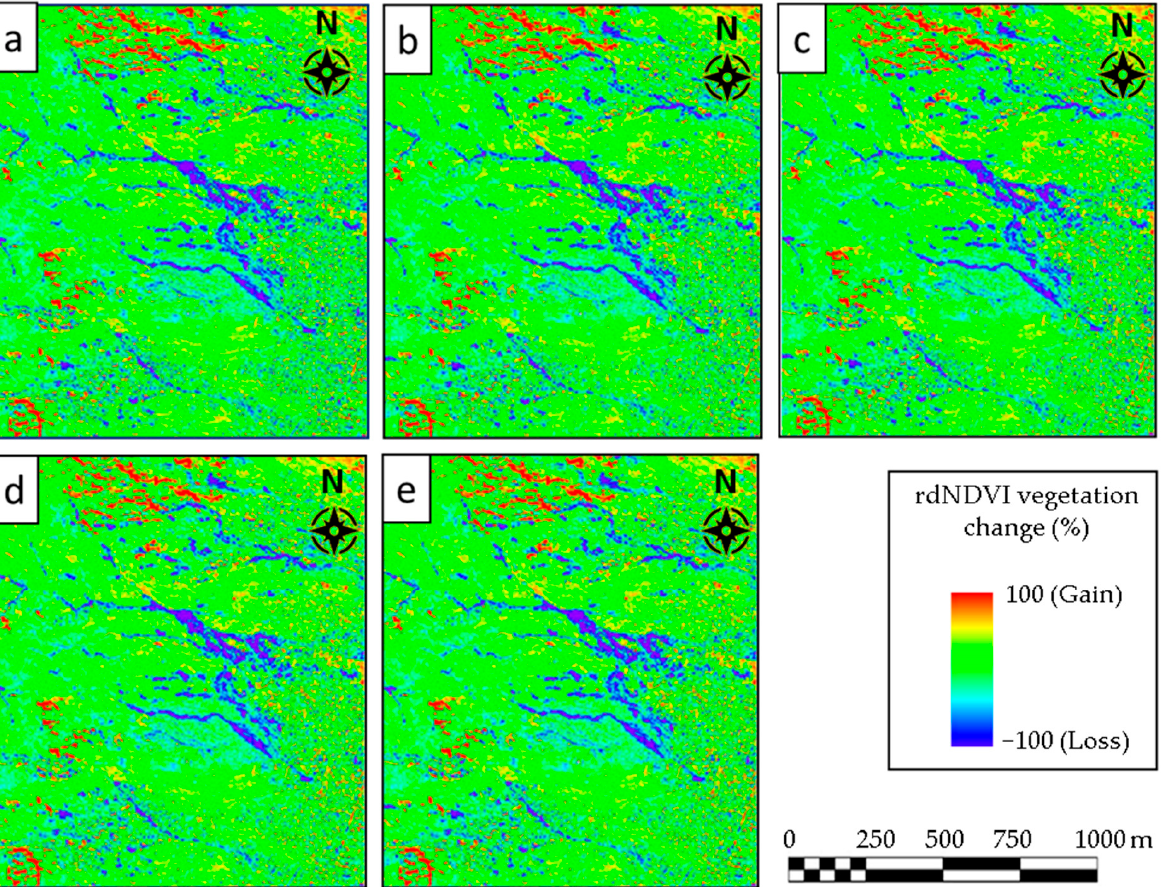
Figure 11. The figure depicts the result of the rdNDVI map for five scenarios. Pre-and post-event images were acquired between 5 June 2020 and 31 October 2020. Figures ( a ) through ( e ) show the rdNDVI results for all available pre- and post-event images used in this study. ( a ) presents the result of rdNDVI, which was generated with only one post-image acquired on 13 September 2020. ( b–e ) represent the results obtained from two, three, four, and five post-event images, respectively.